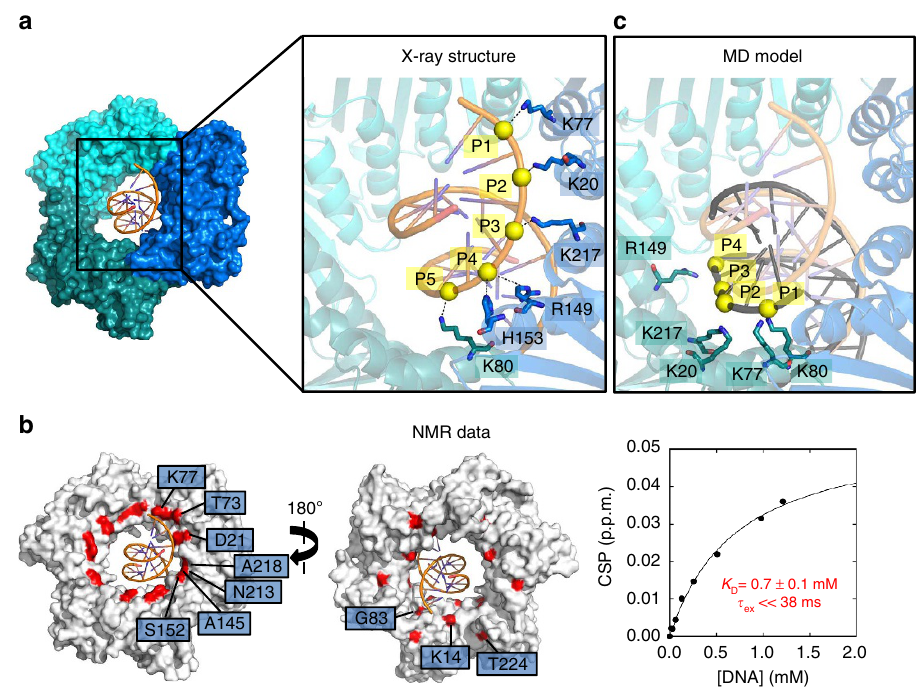
Figure 1 | Structural basis of DNA recognition by human PCNA. ( a ) 2.8Å crystal structure of PCNA bound to a 10bp DNA duplex. PCNA and DNA are shown in surface and ribbon representation, respectively. PCNA subunits are coloured in different shades of blue and DNA in orange. The expansion shows the complex in ribbon representation. Interacting PCNA side chains and DNA phosphates (interatomic side chain nitrogen—DNA phosphorus distance o 5Å) are shown as sticks and yellow spheres, respectively, and interactions as dashed lines ( b ) NMR analysis. Left: front- and back-face views of PCNA surface. PCNA residues whose amide chemical shifts are significantly perturbed by DNA are coloured red. The crystallographic position of DNA is shown in orange. The interacting region in the clamp channel overlaps with that seen in the crystal structure, whereas in the crystal, the side chains can be discriminated, in solution the perturbations involve the backbone amides. Right: chemical shift perturbation of the amide signal of PCNA residue T73 at different DNA concentrations. Fitting was performed using a single-site binding model. Extrapolated dissociation and exchange time constants are indicated. ( c ) Model interface from MD simulation. The crystallographic position of the DNA segment is shown in orange, whereas in black the DNA is shown in a position corresponding to the final state of the 100ns MD simulation of the